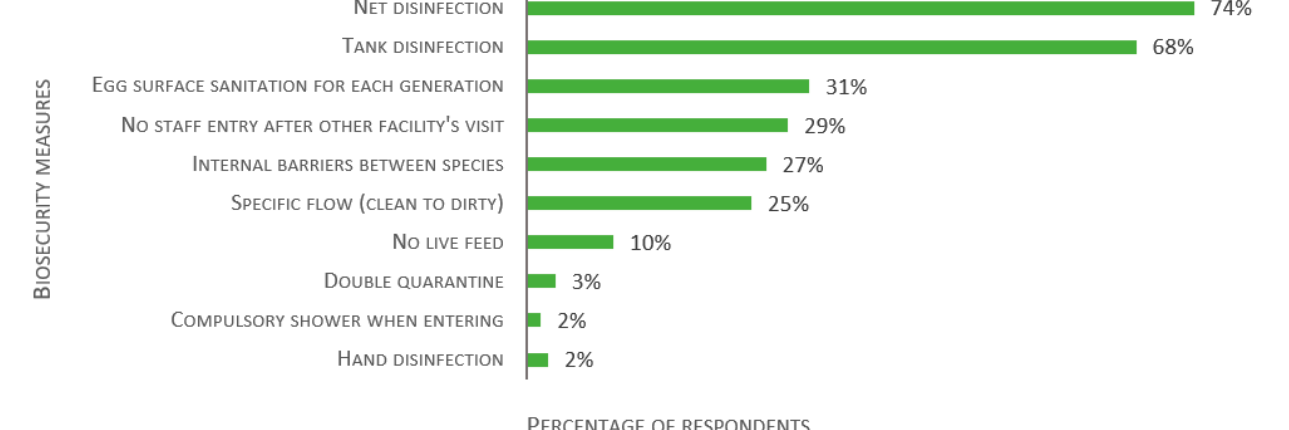
Figure 14. Responses to the multiple-choice question: “Is there any other biosecurity measures or rules in place in your aquatic facility?”, presented as percentage of respondents ( n = 124). Each respondent was allowed to select multiple answers.